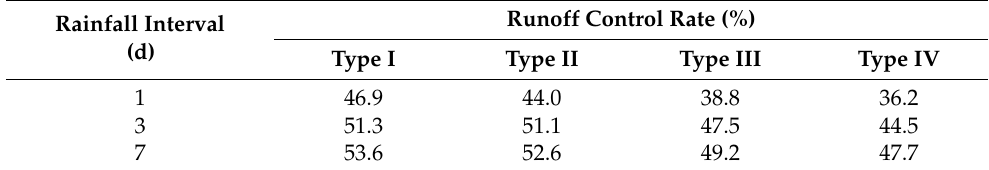
Figure 7. Yield and infiltration amount of each permeable pavement under different rainfall intervals. Table 5. Initial runoff time of each permeable pavement under different rainfall